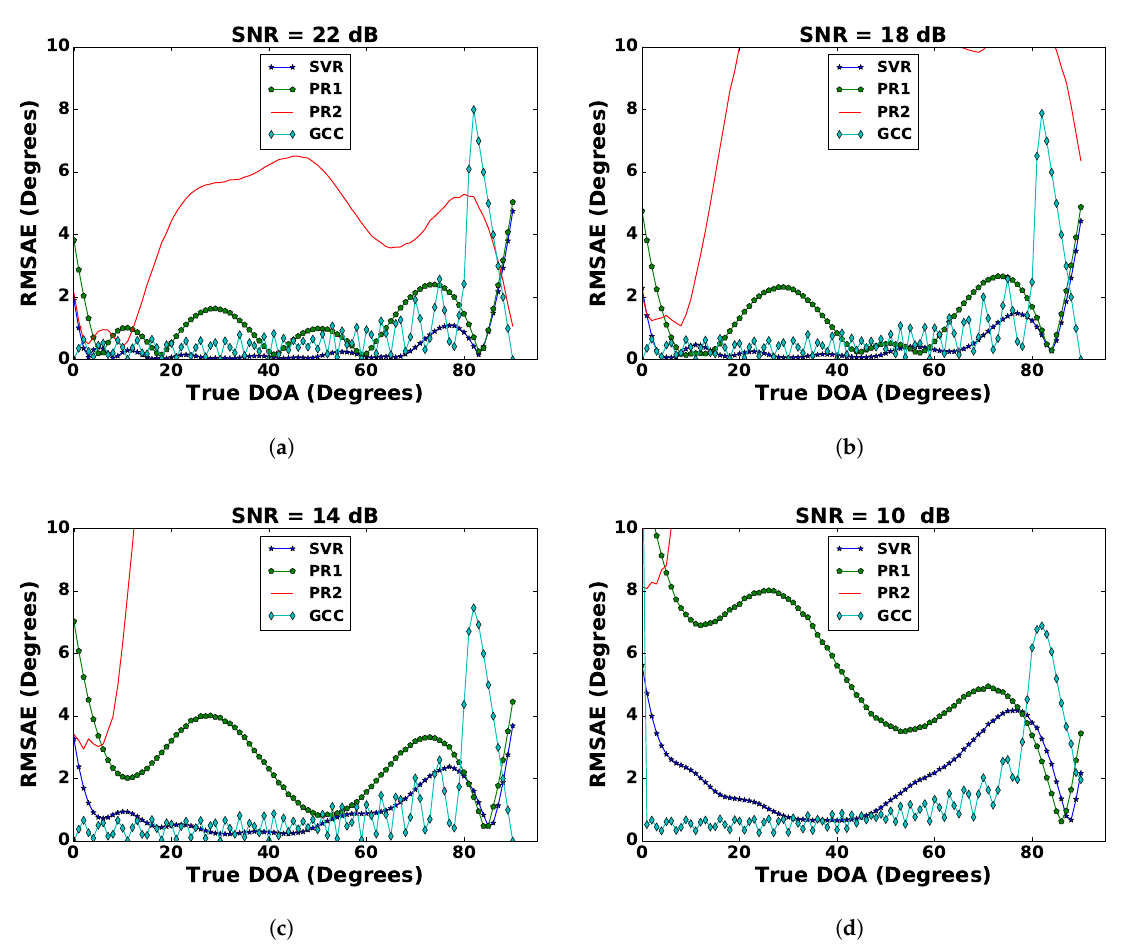
Figure 2. Comparison of different regression techniques (SVR, PR1, and PR2) and the GCC for ( a ) SNR = 22 dB, ( b ) SNR = 18 dB, ( c ) SNR = 14 dB, and ( d ) SNR = 10 dB.